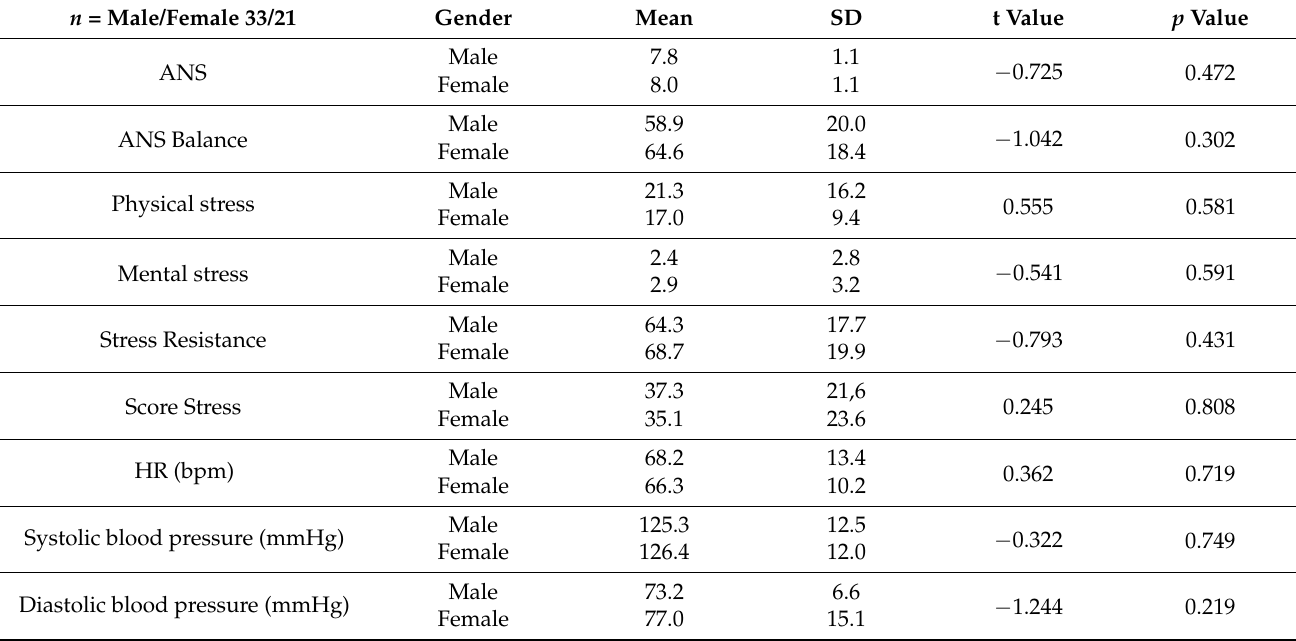
Table 3. Max Pulse ® scores prior to the stress test.